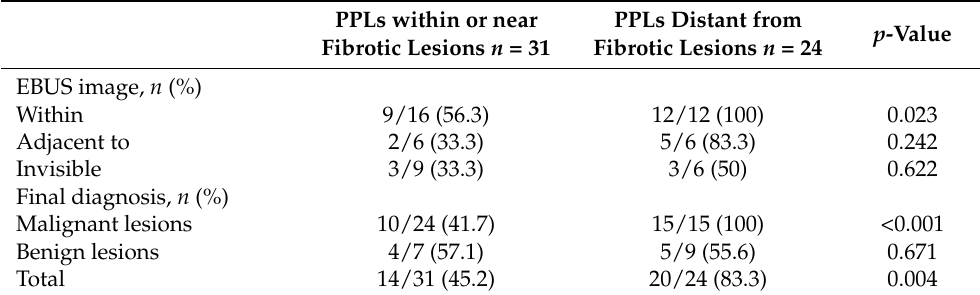
Table 2. Diagnostic yields by probe location and disease type. PPLs within or near